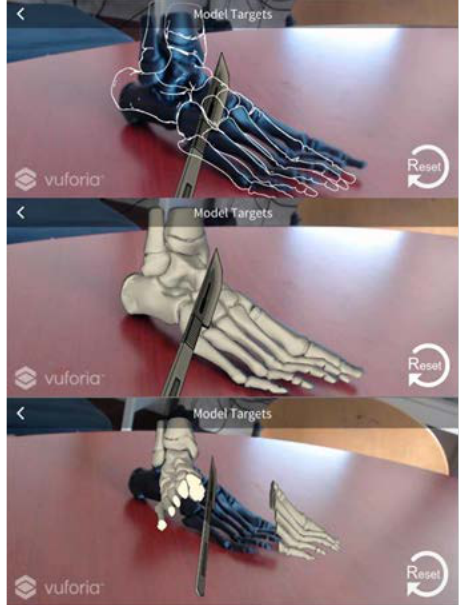
Figure 9. Example of 3d model cutting model.